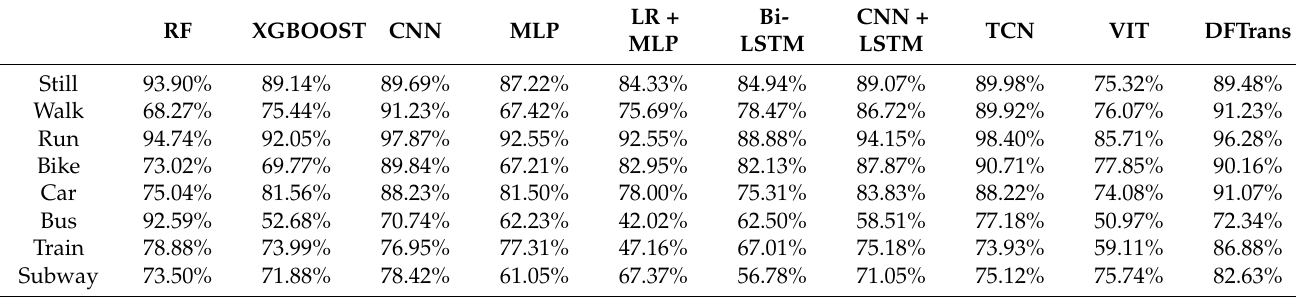
Table 7. Accuracy of different algorithms on the HTC